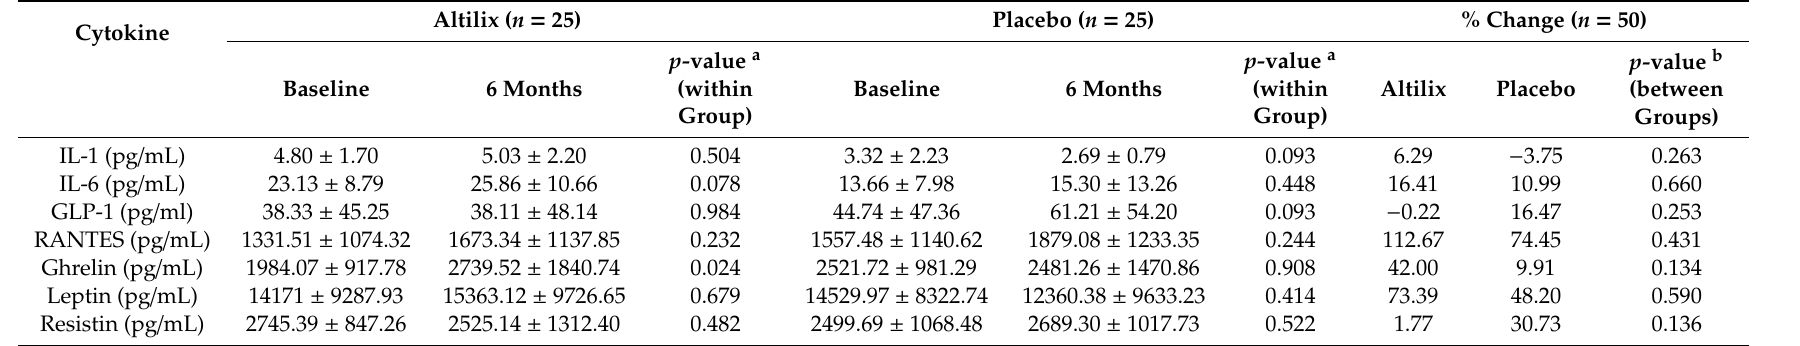
Table 4. Results of cytokine analysis of the patients of the study ( n =